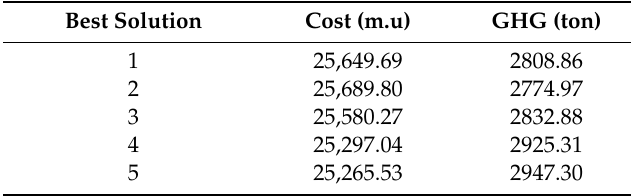
Table 2. Best compromise